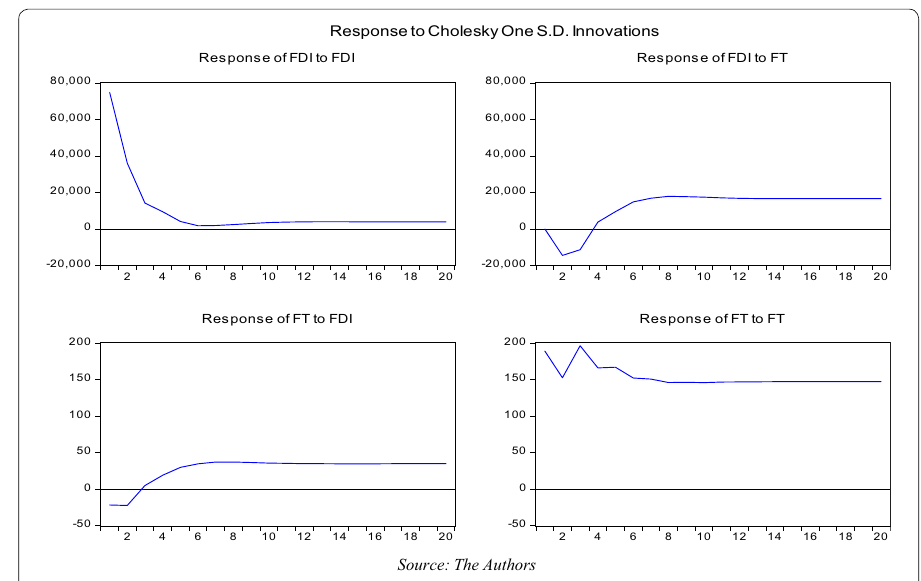
Fig. 2 Impulse responses of FT and FDI to one standard deviation shock in the